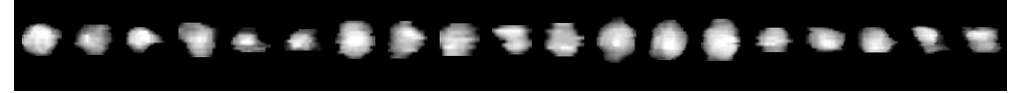
Figure 6. Projected segmentations of 19 nodules, which were artificially inserted into the synthetic